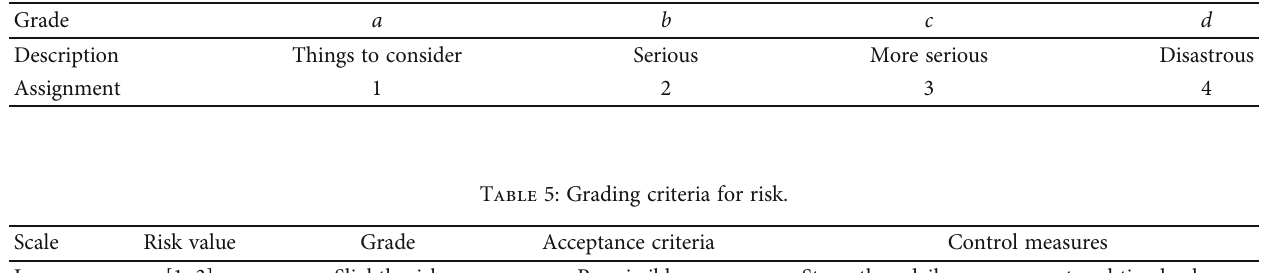
Table 4: Probability level of risk occurrence.